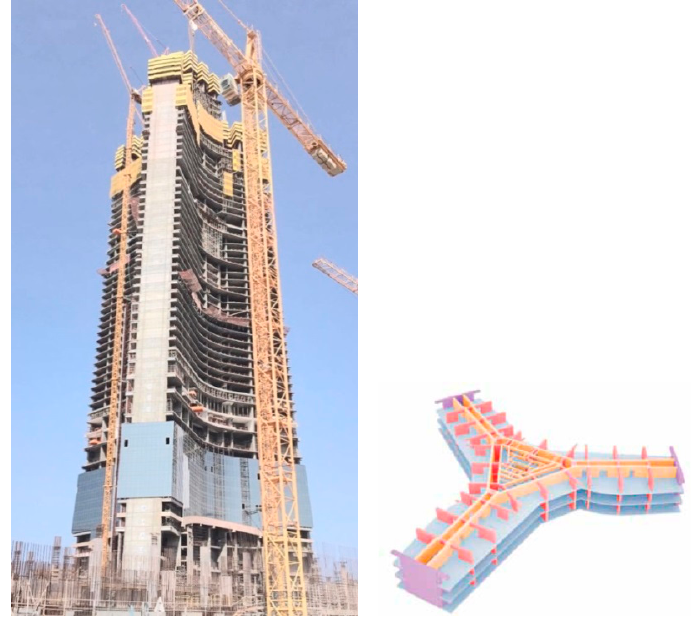
Figure 15. Jeddah Tower under construction (Courtesy of Jeddah Economic Company) and its structural layout (Courtesy of AS+GG & Thornton Tomasetti).